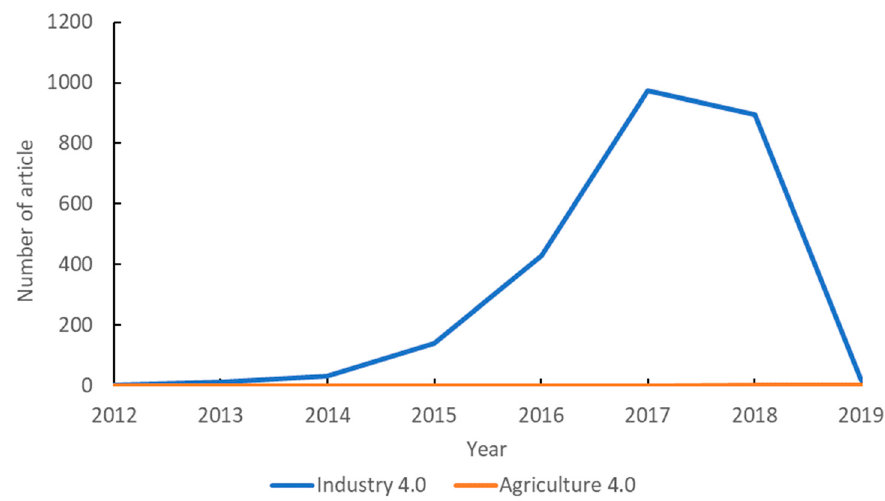
Figure 6. Number of scientific works published year-wise. Source: Own elaboration.